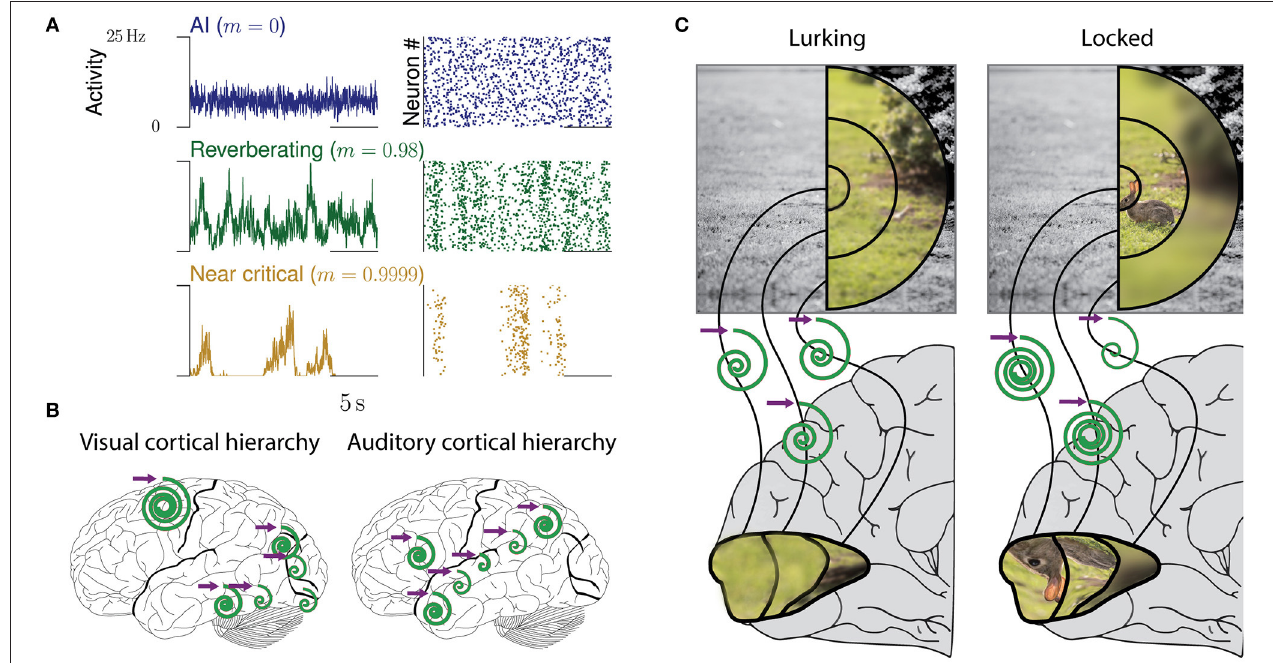
FIGURE 1 | Collective dynamics of cortical networks. (A) Examples of collective spiking dynamics representing either irregular and uncorrelated activity (blue), reverberations (green), or dynamics close to a critical state (yellow). Population spiking activity and raster plots of 50 neurons are shown. (B) Hierarchical organization of collective cortical dynamics. In primary sensory areas, input is maintained and integrated only for tens of milliseconds, whereas higher areas show longer reverberations and integration. The purple arrow represents any input to the respective area, the spirals the maintenance of the input over time (inspired from Hasson et al., 2015 ). (C) Dynamic adaptation of collective dynamics in local circuits. When a predator is lurking for prey, the whole field of view needs to be presented equally in cortex. Upon locking on prey, attention focuses on the prey. This could be realized by local adaptation of the network dynamics, which amplifies the inputs from the receptive fields representing the rabbit (“tuning in”), while quenching others (“tuning